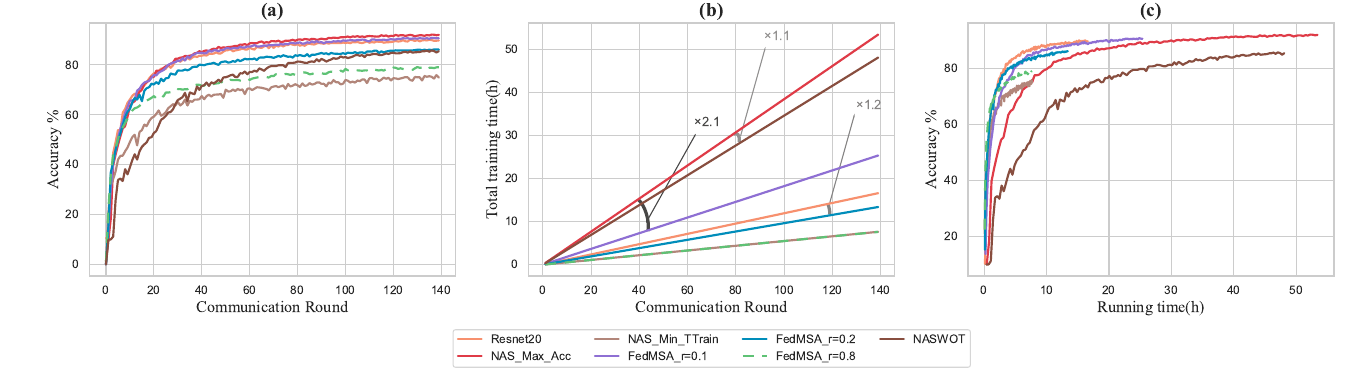
Figure 5. Experiments on Cifar10 under FedMSA system. ( a ) Validation accuracy of models, ( b ) Total training time spend in every communication round of models, ( c ) Changes in model accuracy over